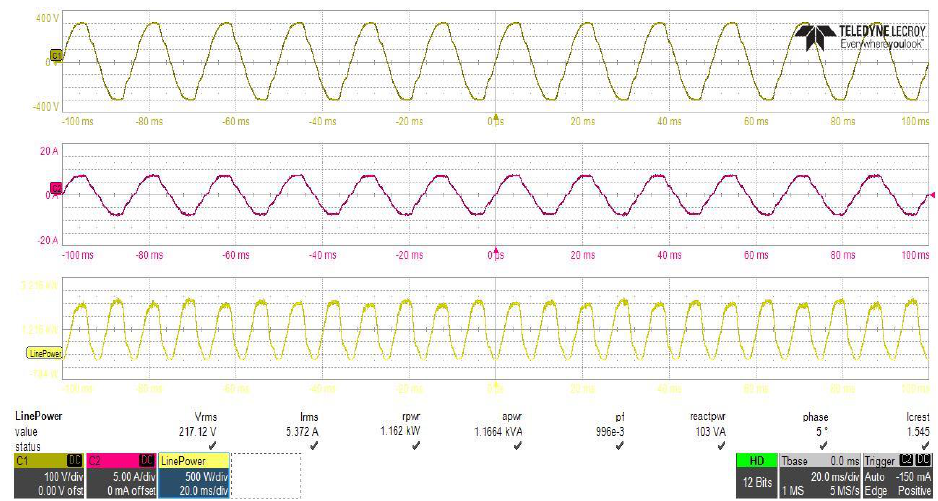
Figure 25. PFC converter stage power analysis with using of the proposed inrush current mitigation circuit.